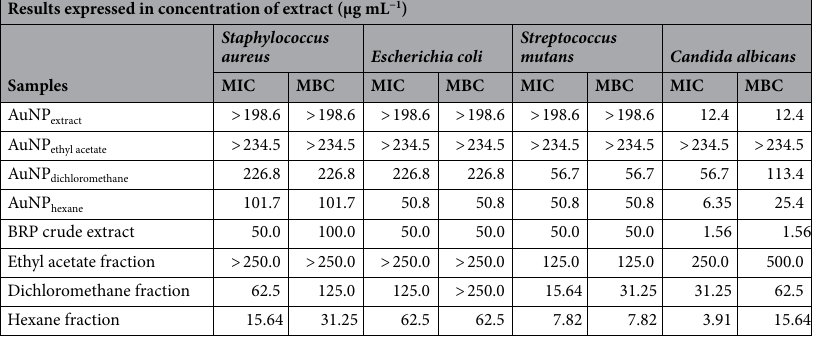
Table 4. Minimum inhibitory concentration (MIC) and Minimum bactericidal concentration (MBC) of biosynthesized gold nanoparticles and BRP crude extract and its fractions against different microorganisms.